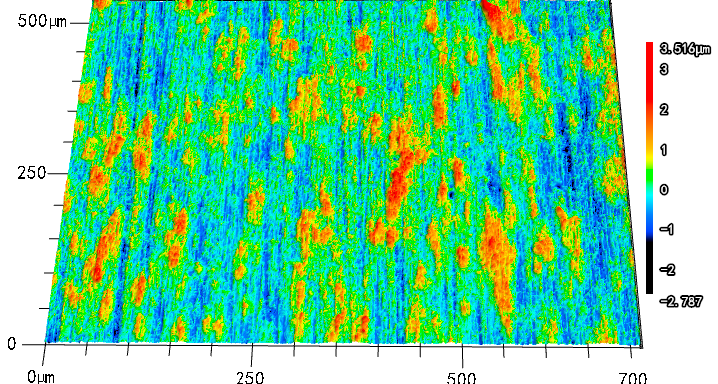
Figure 6. Three dimensional micrograph for the corroded surface of TA2 electrode under glucose concentration of 12 mmol/L.